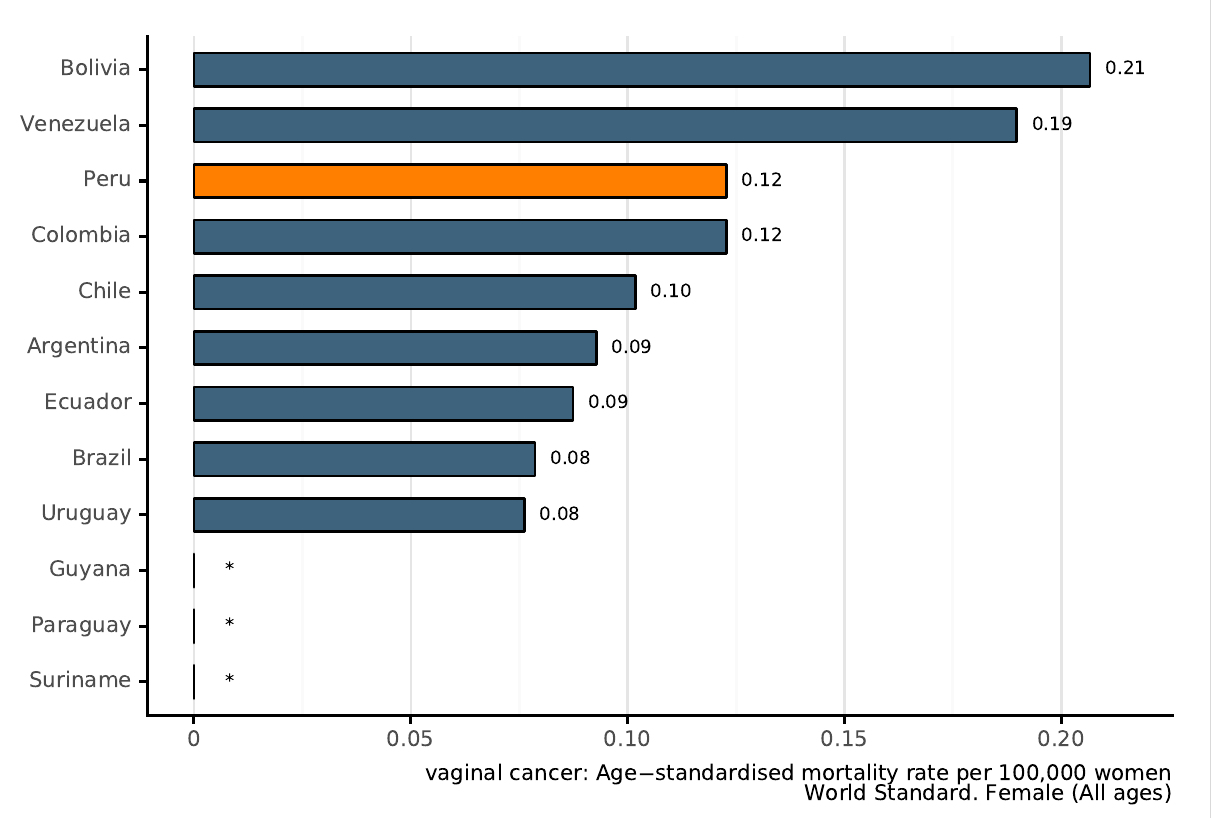
Figure 116: Age-standardised mortality rates of vaginal cancer of Peru (estimates for 2020)